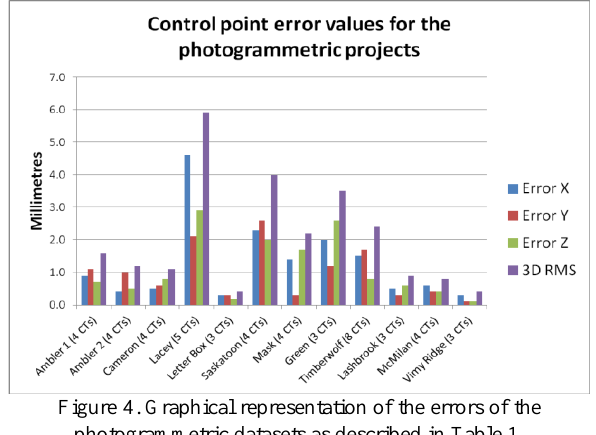
Figure 4. Graphical representation of the errors of the photogrammetric datasets as described in Table